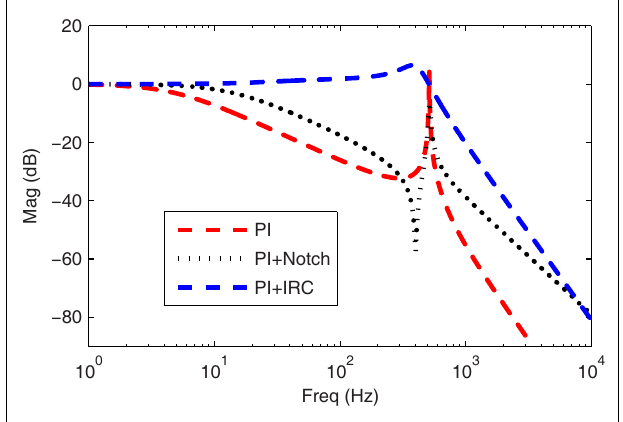
FIGURE 8 | The noise sensitivity of each control strategy .